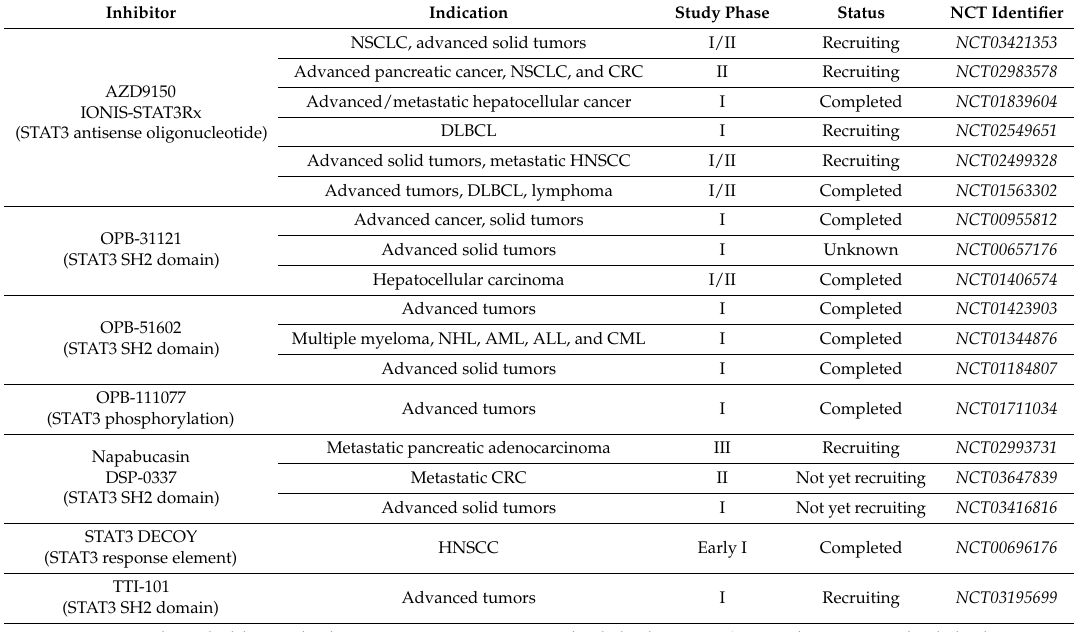
Table 1. Signal transducer and activator of transcription 3 (STAT3) inhibitors currently in clinical